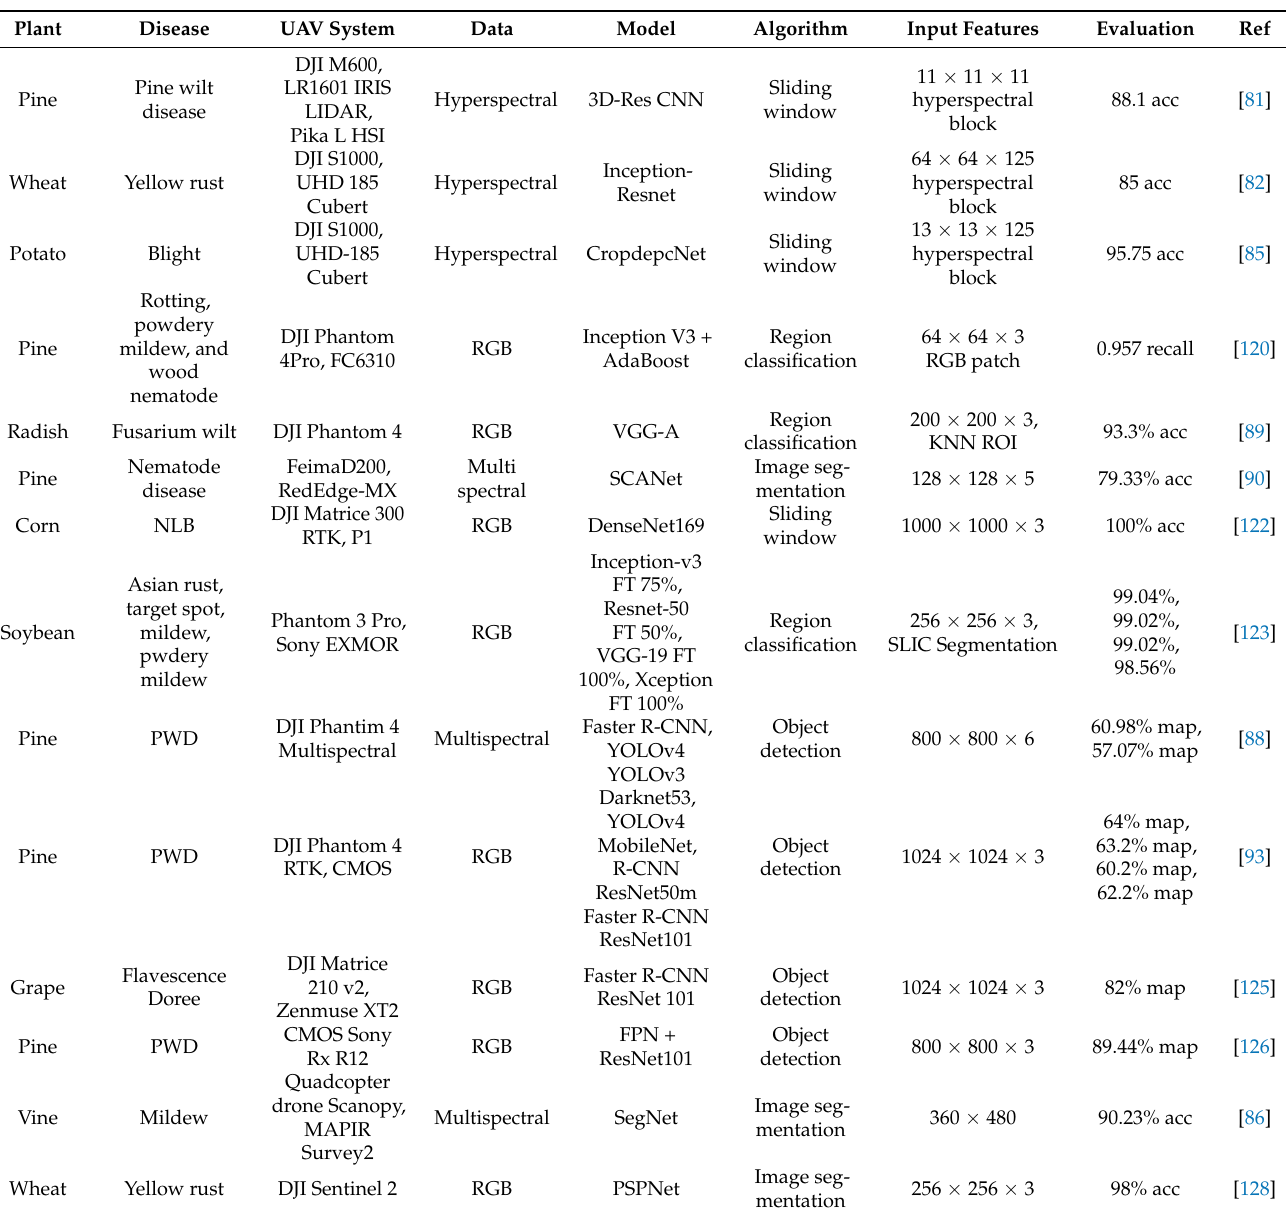
Table 2. Summary of the different methods for disease